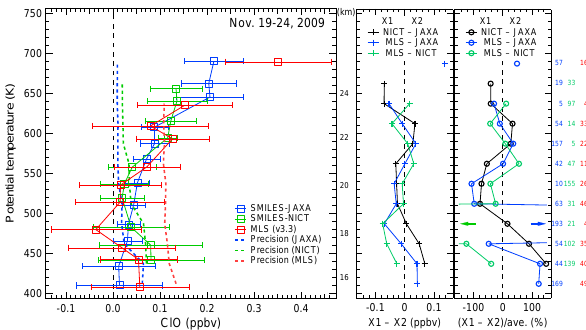
Fig. 4. Same as Fig. 2, but for ClO volume mixing ratios as mea- sured by SMILES and MLS. For clarity, absolute differences are shown in the middle panel. Measurements with solar zenith angles less than 85 ◦ (daytime) are used. Arrows in the right panel show larger relative differences owing to the averages close to